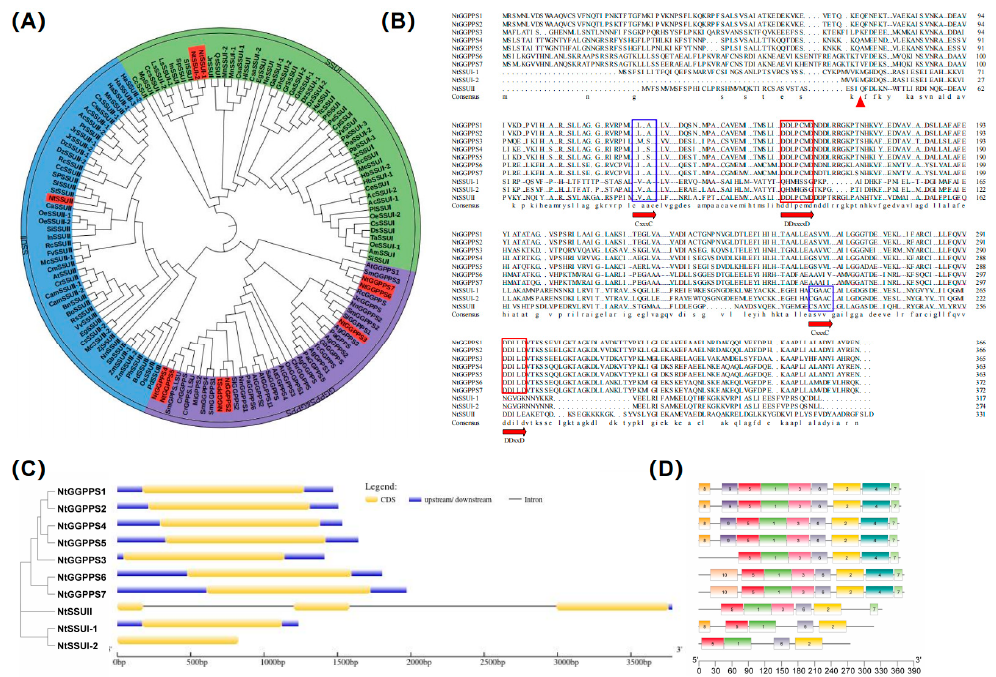
Figure 1. Sequence alignment and phylogenetic analysis of GGPPS family. ( A ) Phylogenetic analysis of GGPPS family. GGPPS family was classified as subgroups of SSU I, SSU II, GGPPS, and GPPS in high plants. ( B ) Sequence analysis of NtGGPPSs and NtSSU. FARM and SARM motifs considered as the binding and catalysis sites were in red boxes. The two conserved domains CxxxC were in blue boxes, which was essential for the interaction of the SSU II protein with other proteins. The putative transit peptides truncated were in red triangle. ( C , D ) The exon-intron structure and conserved motifs in NtGGPPSs and NtSSU. The protein sequences were from NCBI database. NtGGPPS1